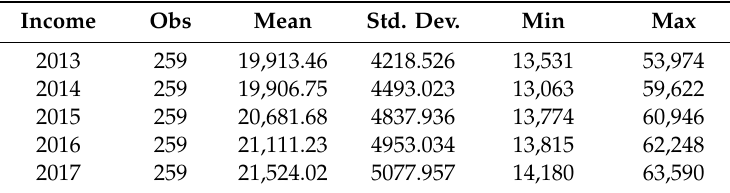
Table 6. Evolution of disposable income ( € / year).